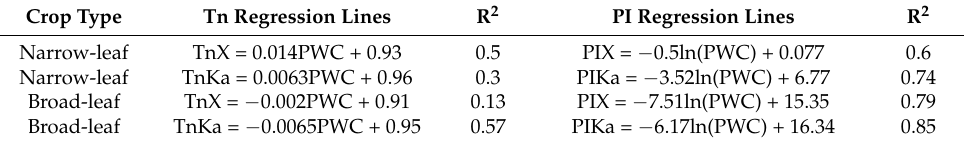
Table 1. Regression equations and R 2 between Tn and PWC, and PI and PWC, at X and Ka bands. CROP TYPE Crop Type Tn Regression